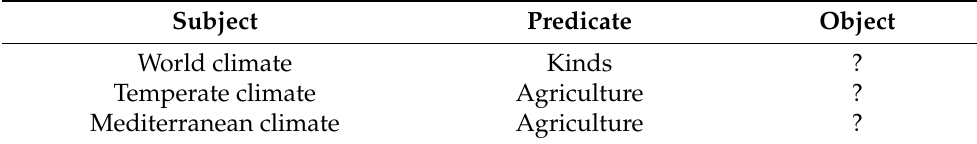
Table 4. Quiz form using triples.